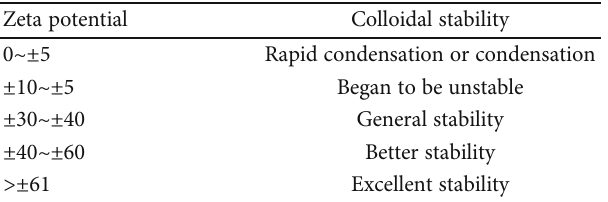
Table 2: Relationship between Zeta potential and solution system